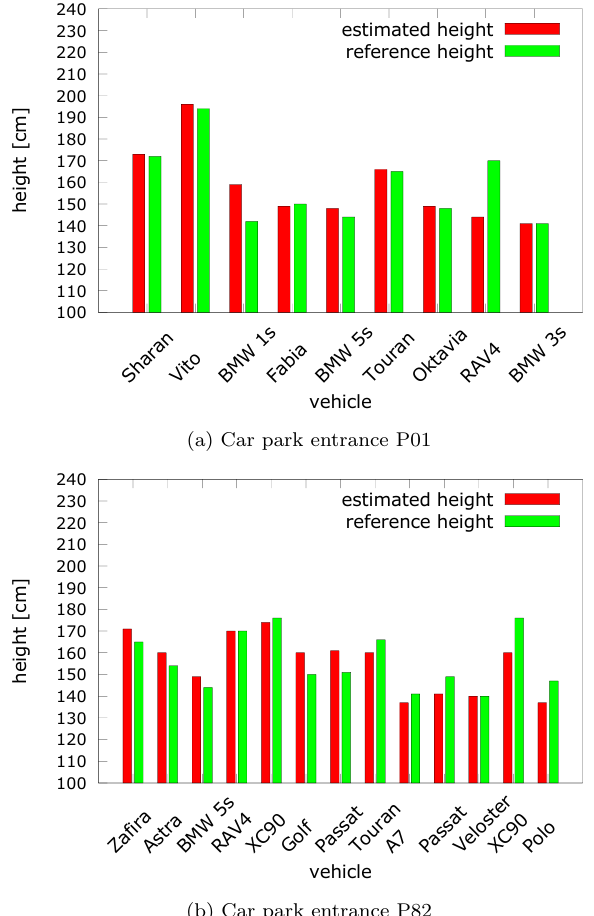
Figure 10: Comparison of the measurement and reference values for the height measurement.